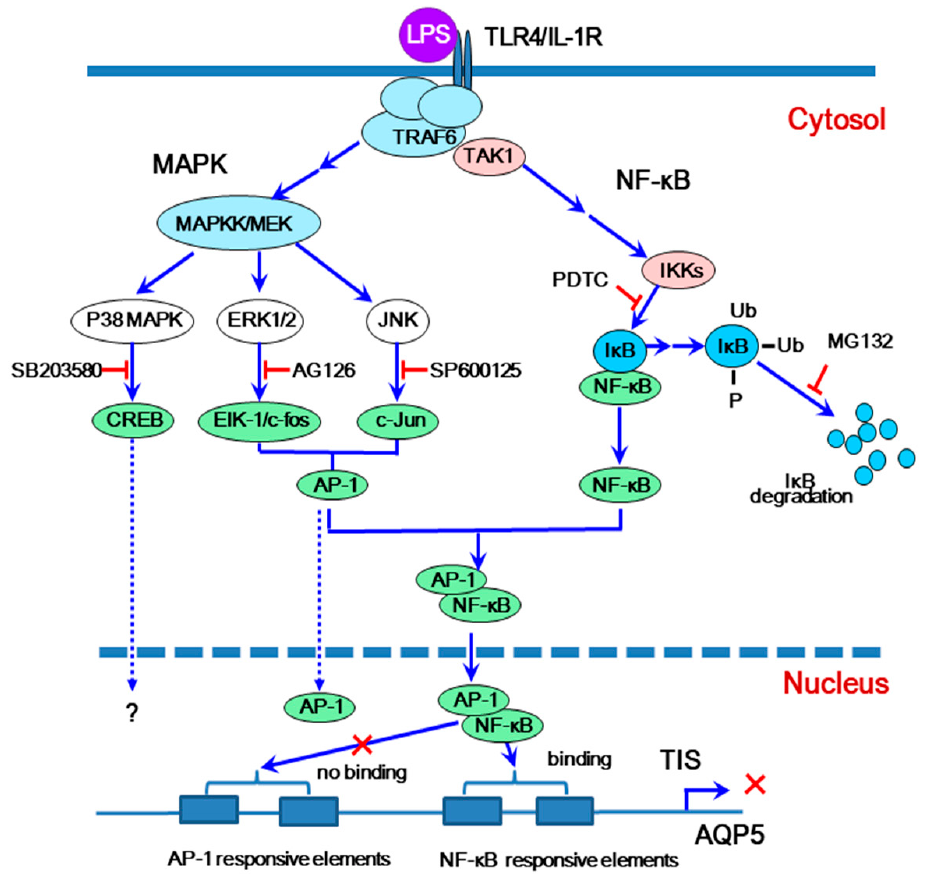
Figure 3. Hypothetical mechanism for lipopolysaccharide (LPS)-induced signaling and downregulation of AQP5 transcription via cross-coupling of mitogen-activated protein kinase (AP-1) and nuclear factor-kappa B (NF- κ B) (a model proposed from mouse experiment). TIS, transcription initiation site.